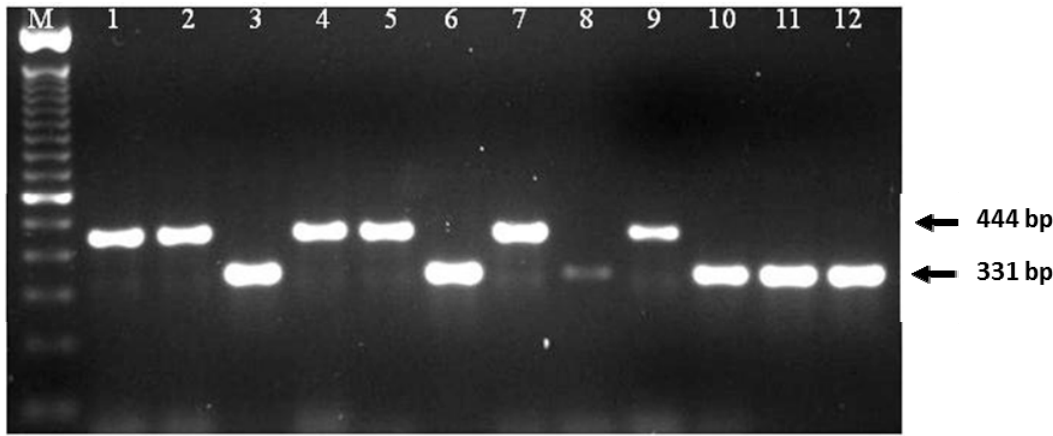
Figure 2. Blackleg isolates identified using species-specific polymerase chain reaction (PCR) assay. Lanes: M-100bp DNA ladder; 1, 2, 4, 5, 7, 9–– Leptosphaeria biglobosa “ brassicae ” (444 bp); 3, 6, 8, 10, 11, 12–– Leptosphaeria maculans “ brassicae ” (331 bp).